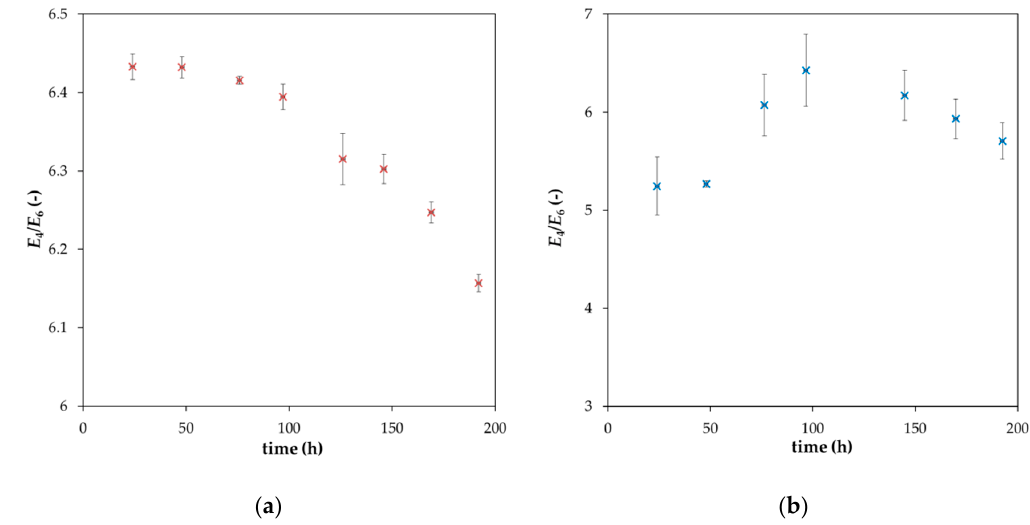
Figure 7. E 4 / E 6 ratio of lignuhumate in its solution during its diffusion into the hydrogel ( a ); time development of E 4 / E 6 ratio of lignohumate in the hydrogel at a distance of 0.5 mm from the interface ( b ).